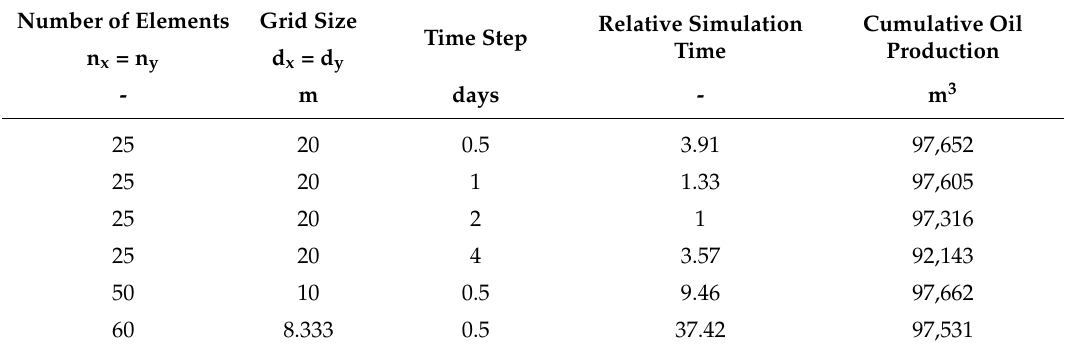
Table 5. Comparison of several waterflooding simulations using the iterative IMPEC method. Number of